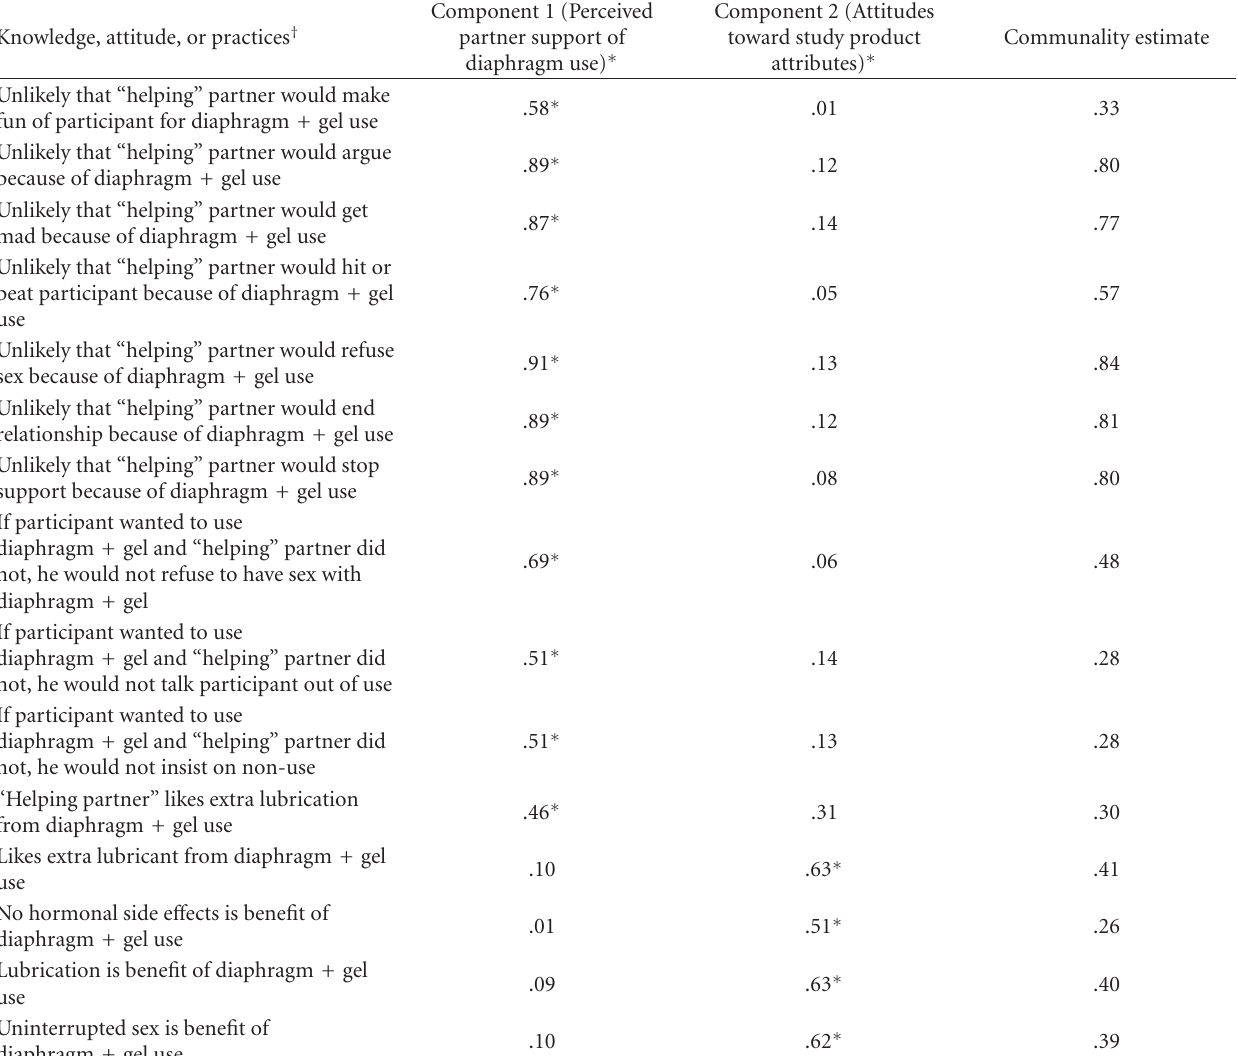
Table 2: Rotated factor pattern and final communality estimates from principal component analysis of participants’ (and participants’ perception of partners’) knowledge, attitude, or practices regarding diaphragm use with “helping” partner, Nairobi, Kenya, 2004-2005 ∗